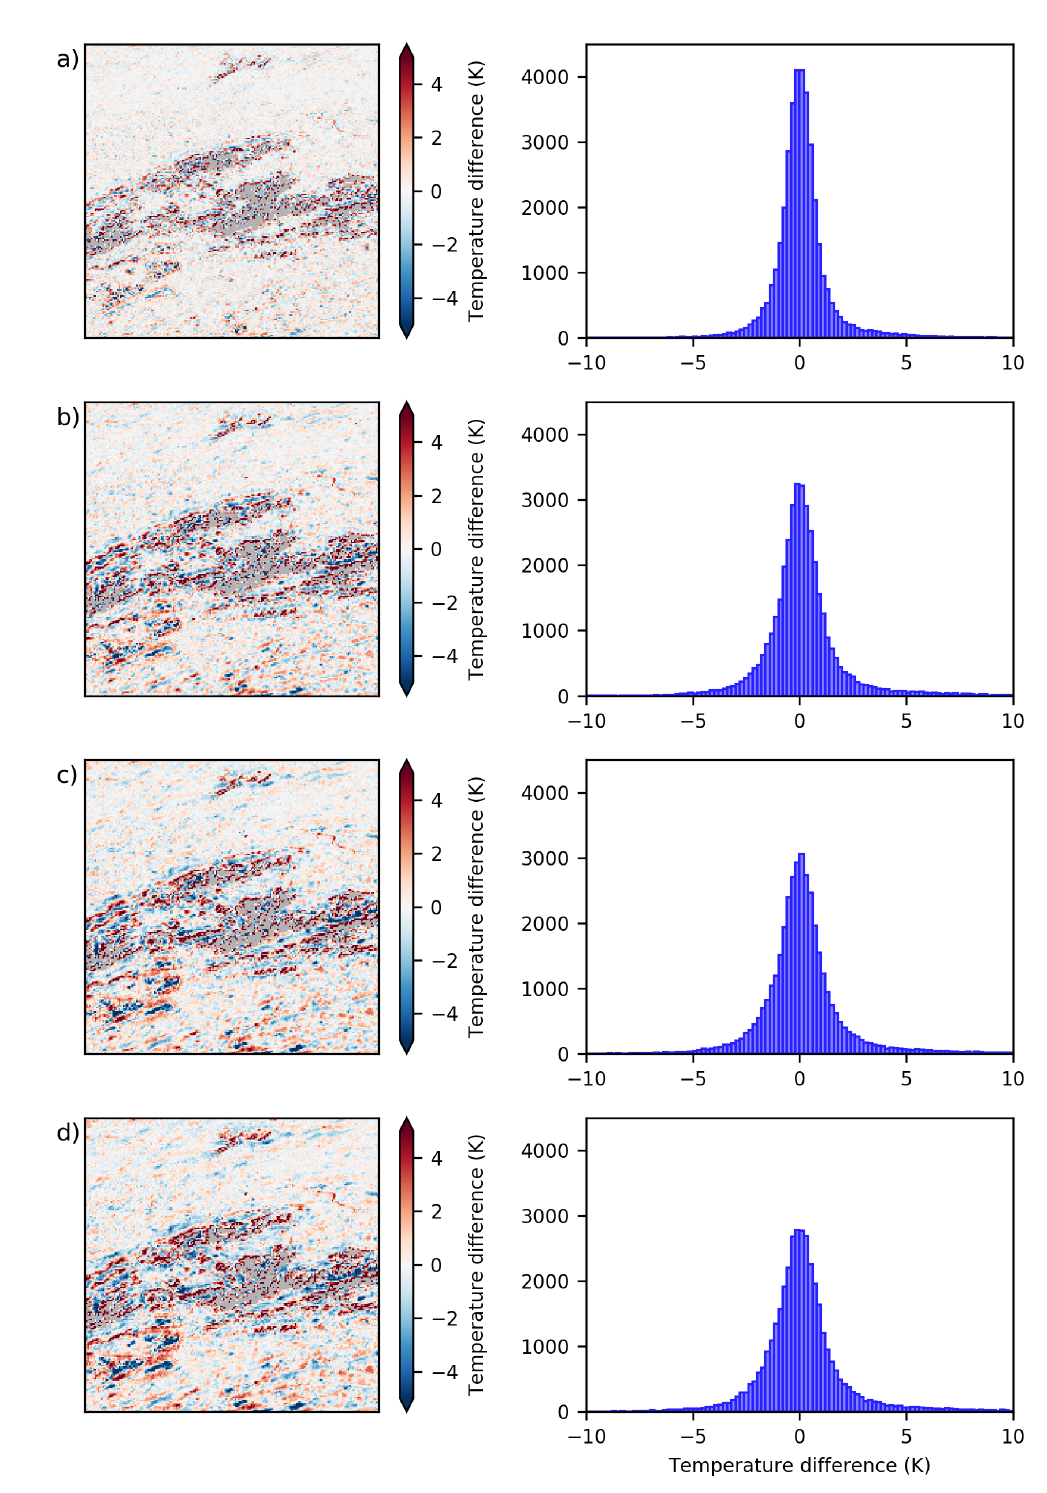
Figure A5. Changes in the spatial and statistical distribution of temperature estimates for the central Siberian (sib) study area by window size. Window levels shown are ( a ) 5 × 5 window; ( b ) 7 × 7 window; ( c ) 9 × 9 window; and ( d ) 11 × 11